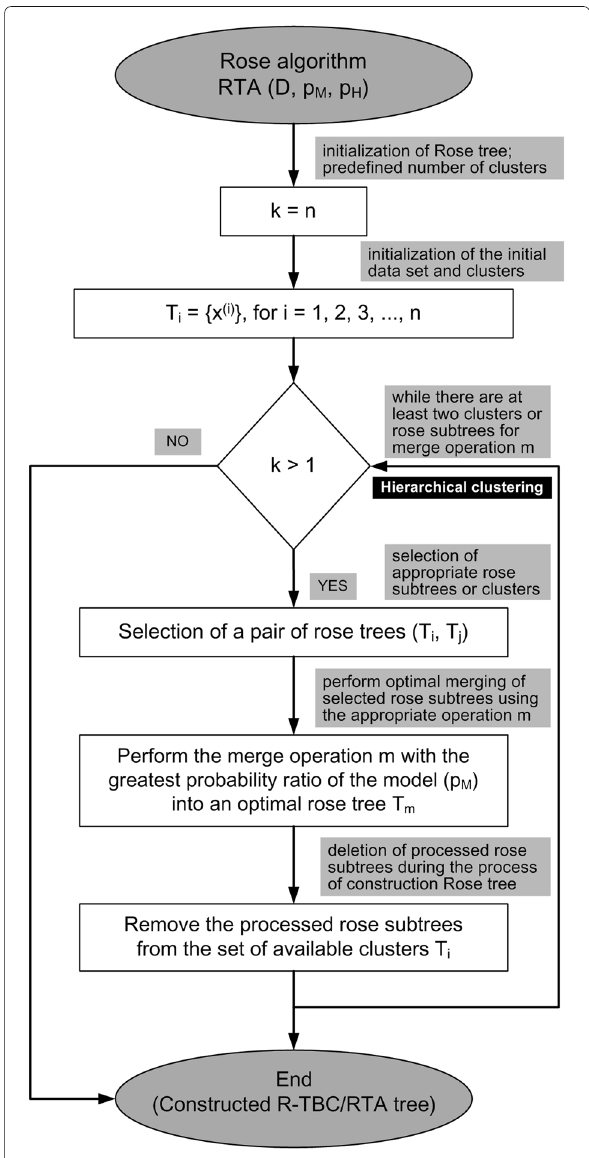
Fig. 6 Rose Tree Algorithm for construction of the R-TBC consistency tree with replica servers of heterogeneous transactional cloud DBMS